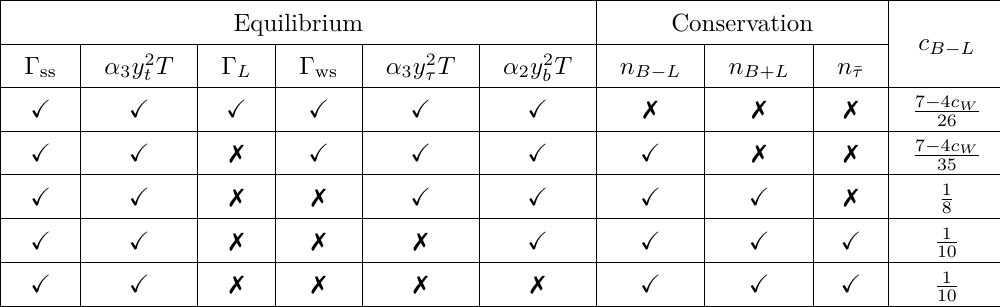
Table 1 . Values of c B − L for different sets of interactions in equilibrium using simplified Boltzmann equations presented in appendix